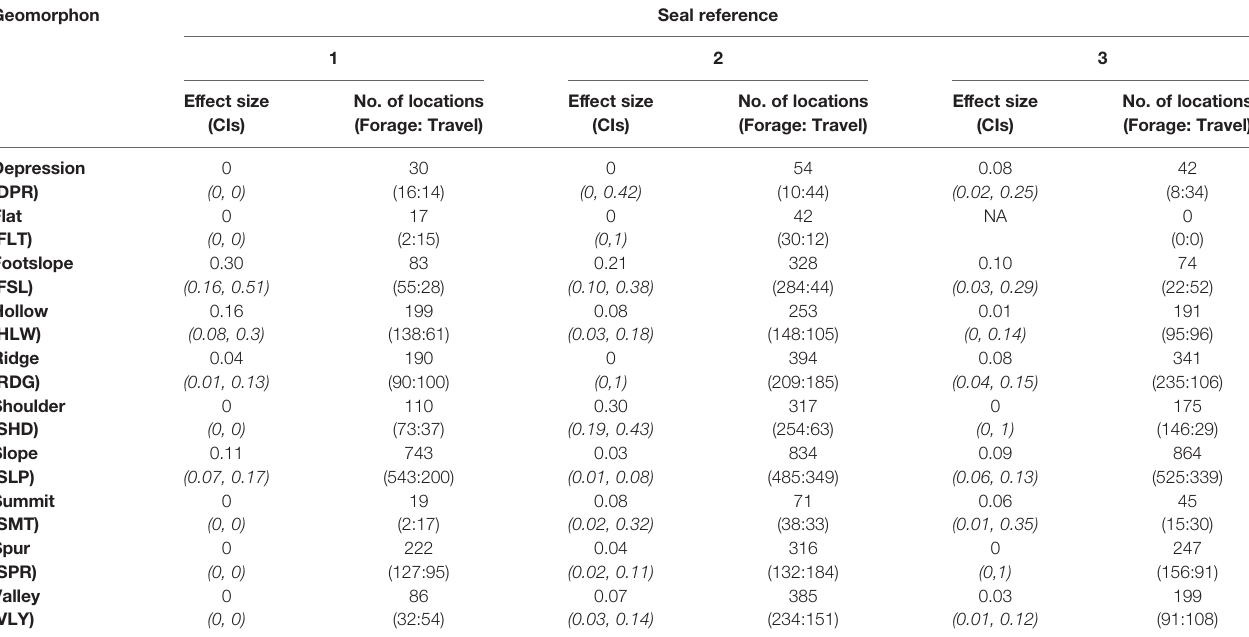
TABLE 3 | Effect sizes with 95% con fi dence intervals (CIs) for the probabilities of transitioning between travelling and foraging for each seal for each geomorphon.